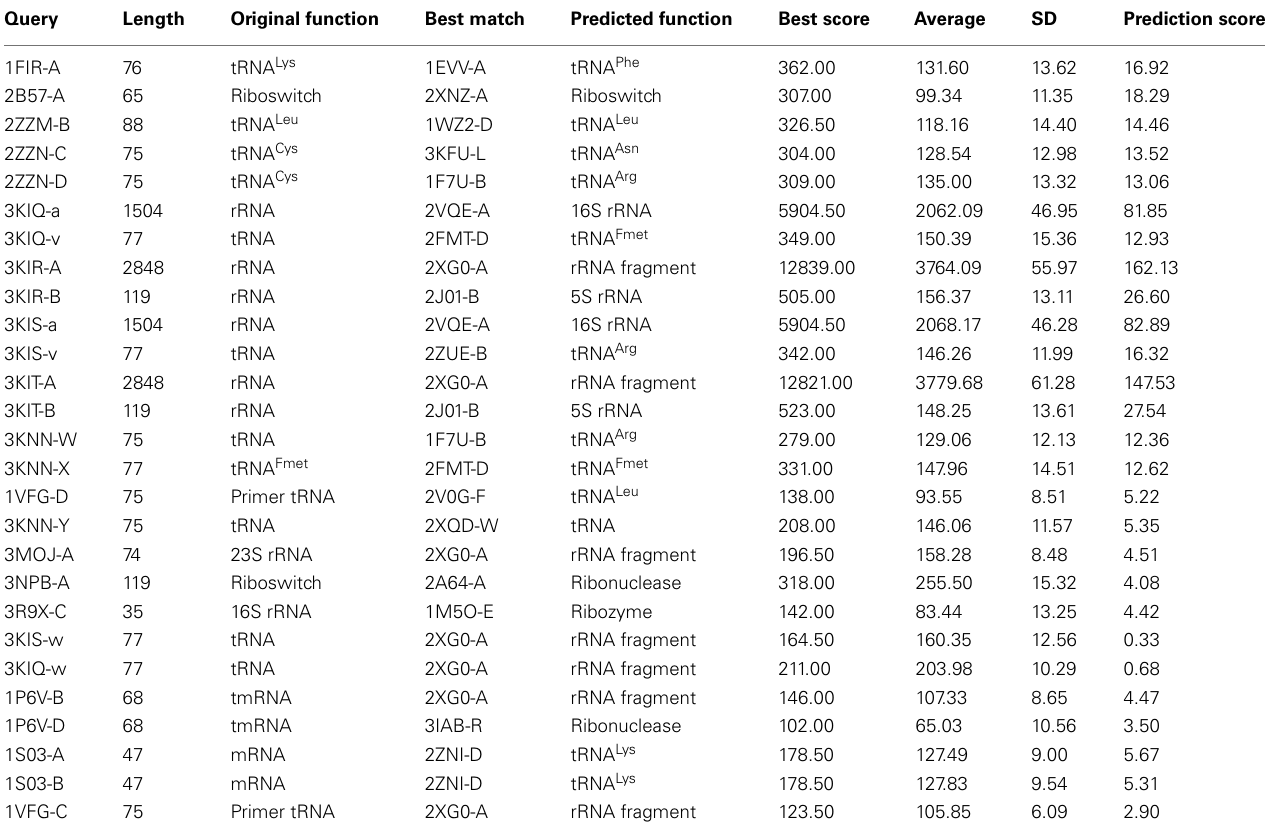
Table 4 | Function assignment to RNAs of the other-RNA